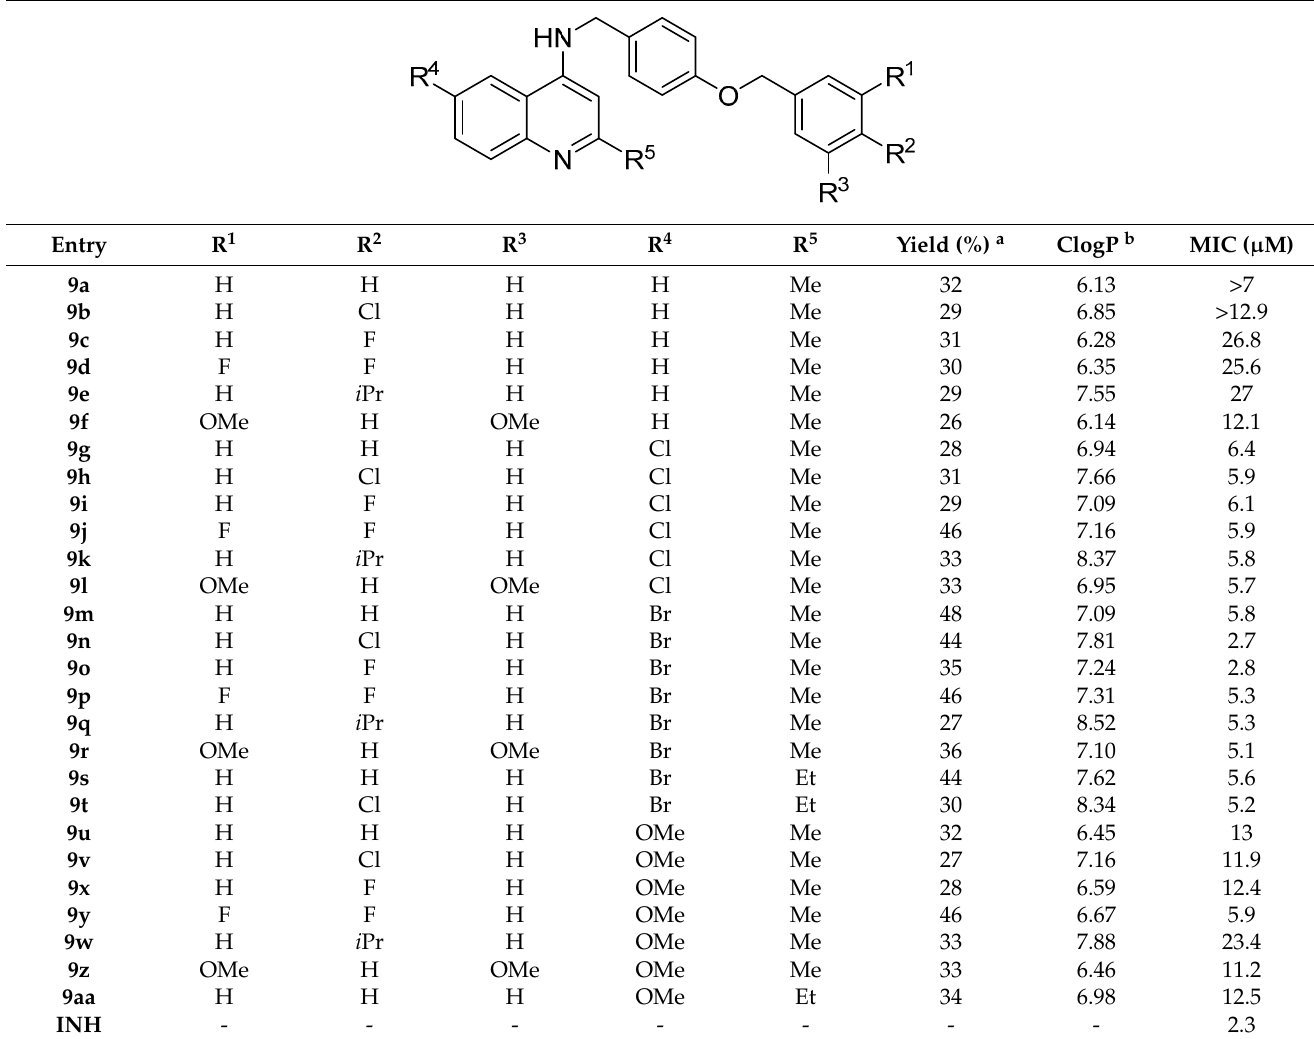
Table 1. Yields after purification of 4-amino- N -(4-benzyloxy)quinolines 9a – 9aa , ClogP values, and in vitro activity against M. tuberculosis H37Rv.